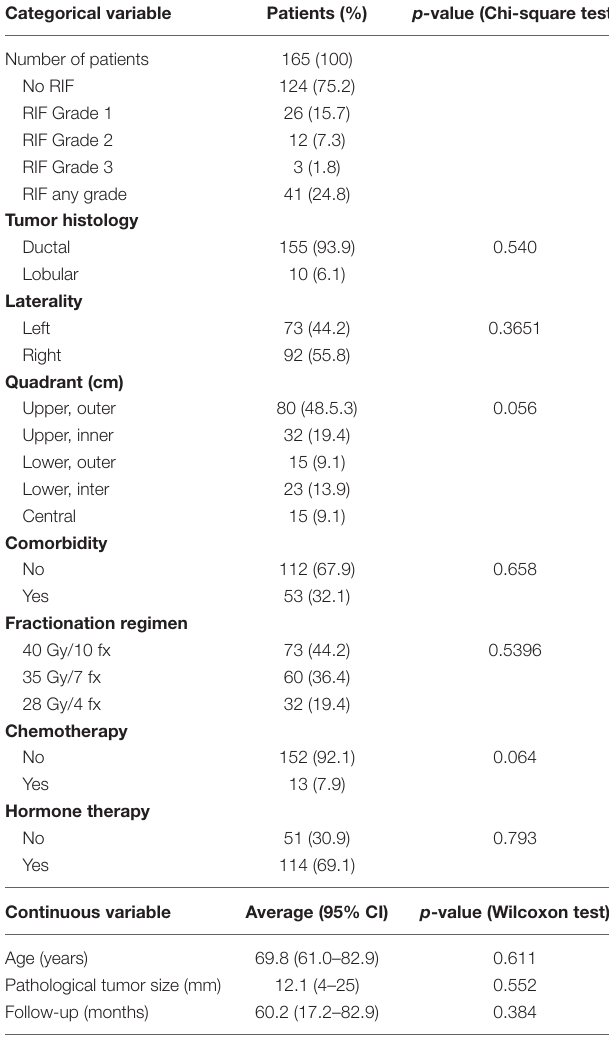
TABLE 1 | Patients characteristics with statistical tests to investigate correlation with RIF. Categorical variable Patients